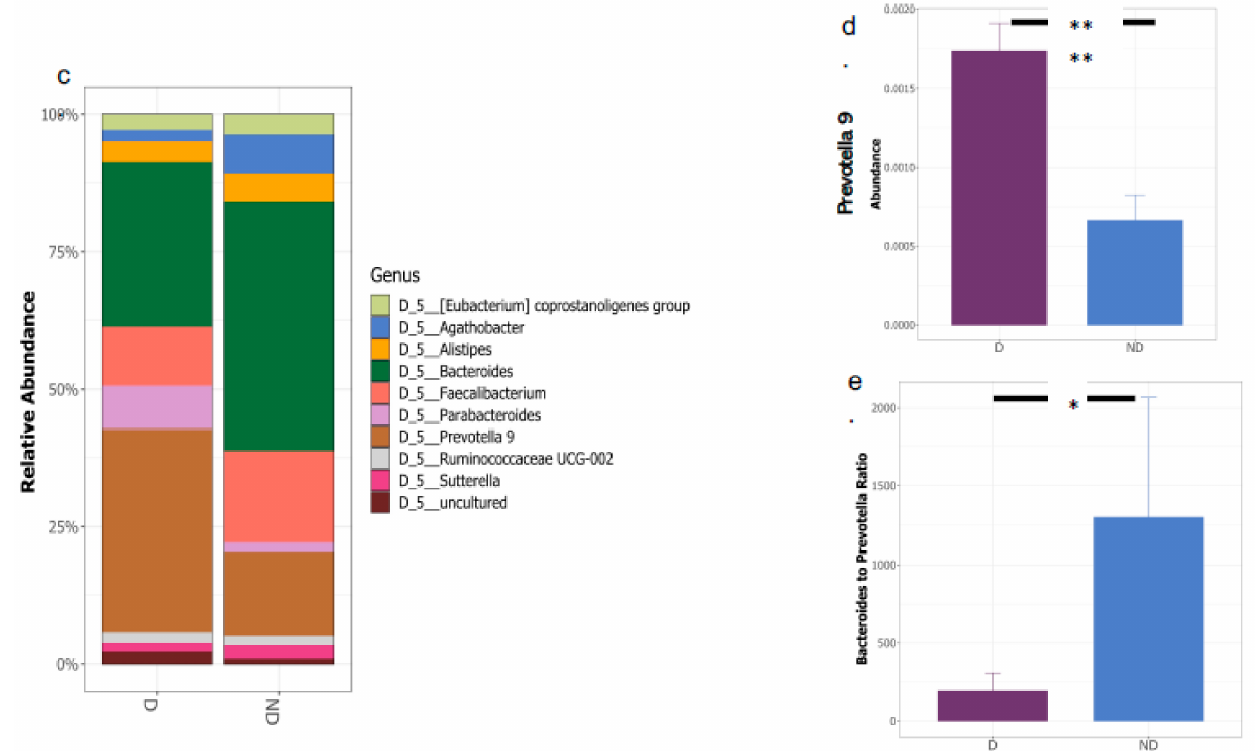
Figure 3. Comparison of the gut microbiota composition in vitamin D deficient (D) and non-deficient (ND) groups at the phylum level. ( a ) Relative abundance of different bacterial phyla in the deficient and non-deficient groups. The relative abundance of the major bacterial phyla, Firmicutes and Bacteroidetes, showed variation between the two groups. The abundance of Phylum Bacteroidetes was significantly elevated in the D group as compared to ND (Wilcoxon test with false discovery rate (FDR)–Bonferroni corrected, * p < 0.05). The figure was generated using RStudio v 1.4 with R v 4.1. ( b ) Comparison of the ratio of Bacteroidetes to Firmicutes in vitamin D deficient (D) and non-deficient (ND) groups (Wilcoxon test with false discovery rate (FDR)–Bonferroni corrected, * p < 0.05). The figure was generated using RStudio v 1.4 with R v 4.1. Comparison of the gut microbiota composition in vitamin D deficient (D) and non-deficient (ND) groups at the genus level. ( c ) Relative abundance of different bacterial genus in the deficient and non-deficient groups. The relative abundance of the major bacterial genera, Prevotella and Bacteroides , showed variation between the two groups. ( d ) Abundance of genus Prevotella 9 was significantly elevated in the D group as compared to ND. ( e ) Comparison of the ratio of Bacteroides to Prevotella in vitamin D deficient (D) and non-deficient groups (ND) groups (Wilcoxon test with false discovery rate (FDR)–Bonferroni corrected, * p <